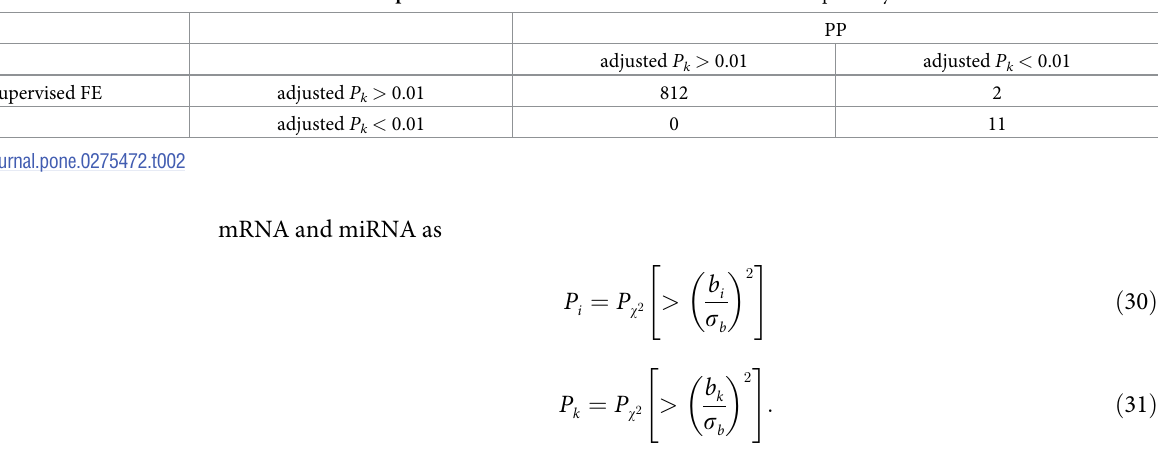
Table 2. Confusion matrix of selected miRNAs between TD-based unsupervised FE and PP in the first data set. P -value computed by Fisher’s exact test is 2.76 × 10 − 23 .